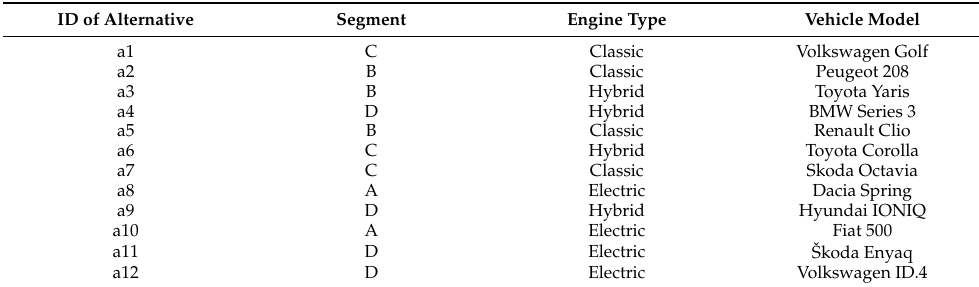
Table 1. Cars (variants) included in the analysis.